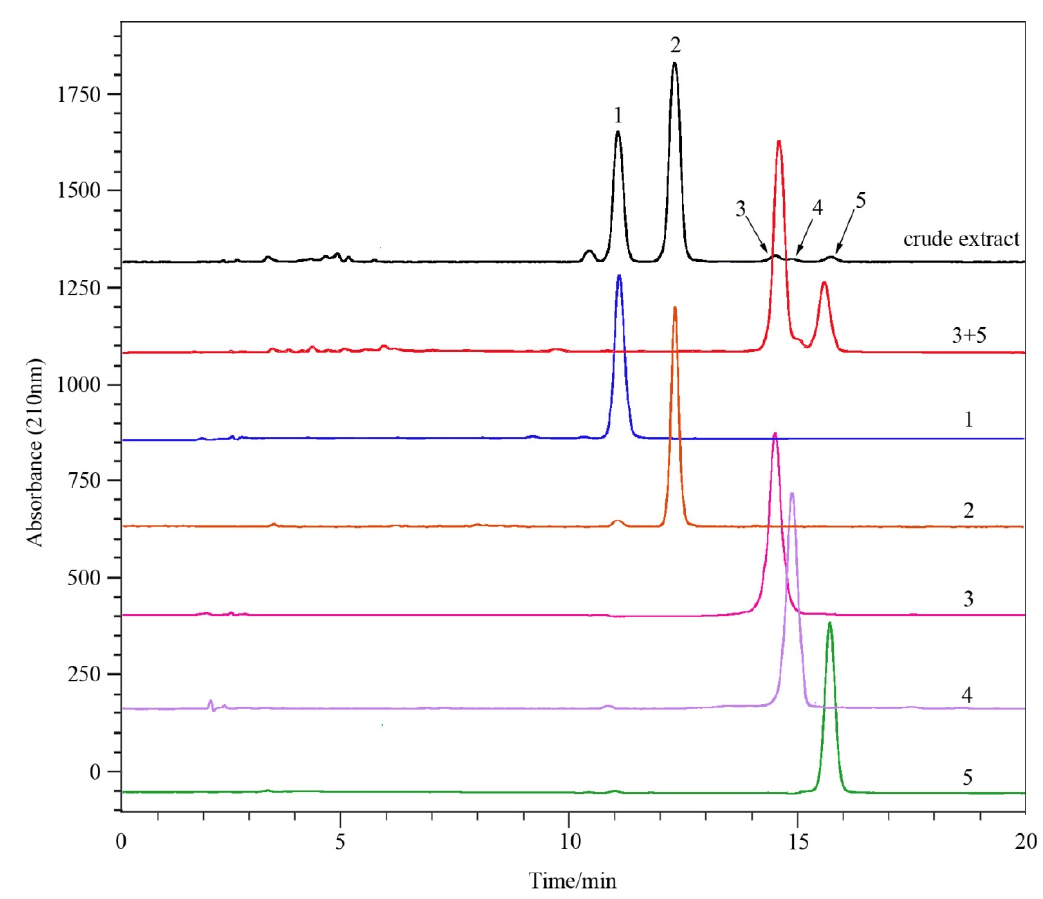
Figure 5. HPLC chromatograms of crude extract and HSCCC fraction of compounds 1 – 5 . Column: waters C 18 column (4.6 × 250 mm, 5 μm); mobile phase: methanol-water (95:5, v / v ); wavelength: 210 nm; flow rate: 1 mL/min.